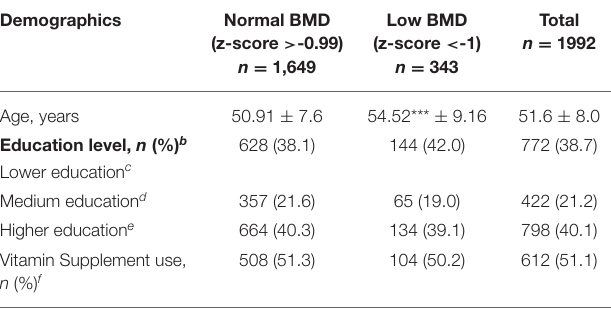
TABLE 1 | Characteristics of the study population according to BMD category a .